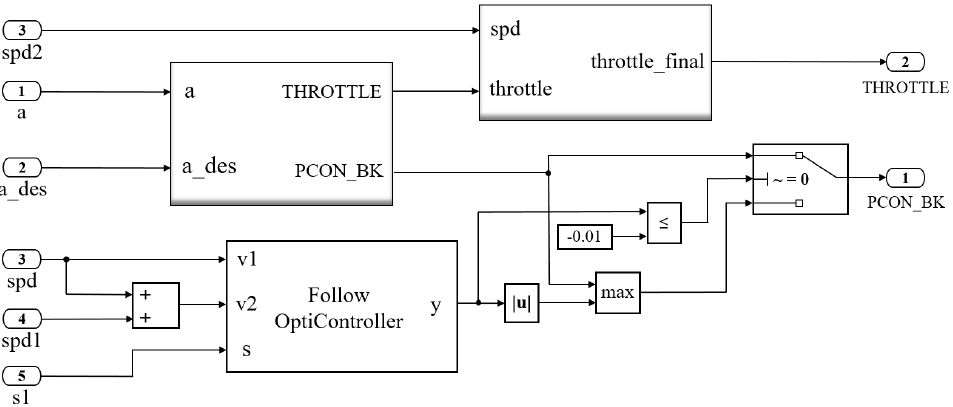
Figure 11. Switching logic of the proposed vehicle-following model.